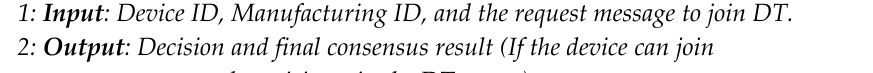
Algorithm 1 Blockchain Authentication & Verification Algorithm 1. Blockchain Authentication &